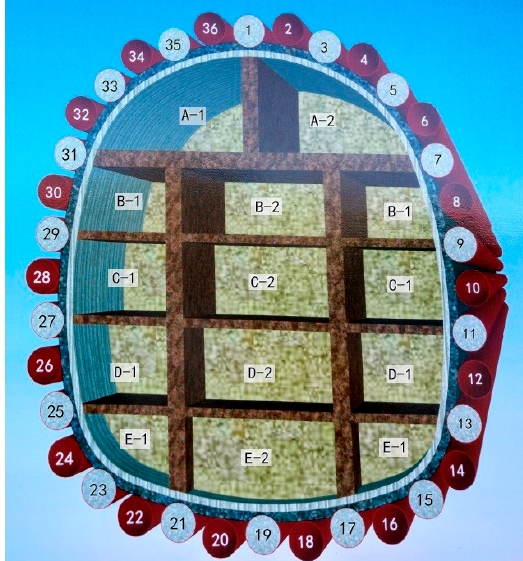
Figure 1. Schematic of the tunnel section.